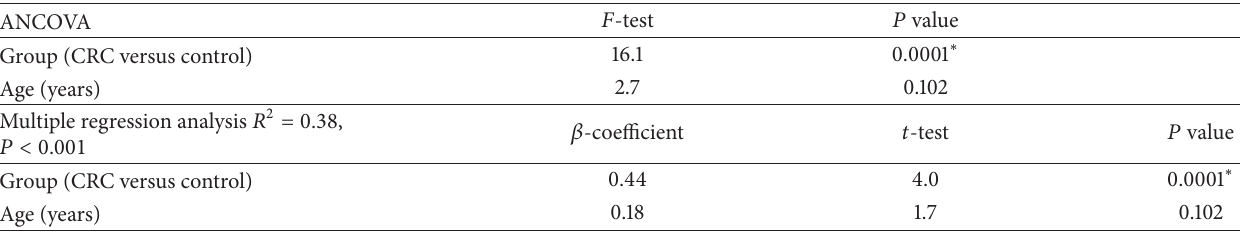
Table 2: ANCOVA and multiple regression analysis for o-LAB as a dependent variable (age parameter as a continuous covariate). ANCOVA 𝐹 -test 𝑃 value Group (CRC versus control) 16.1 Multiple regression analysis 𝑅 2 = 0.38 , 𝑃 < 0.001